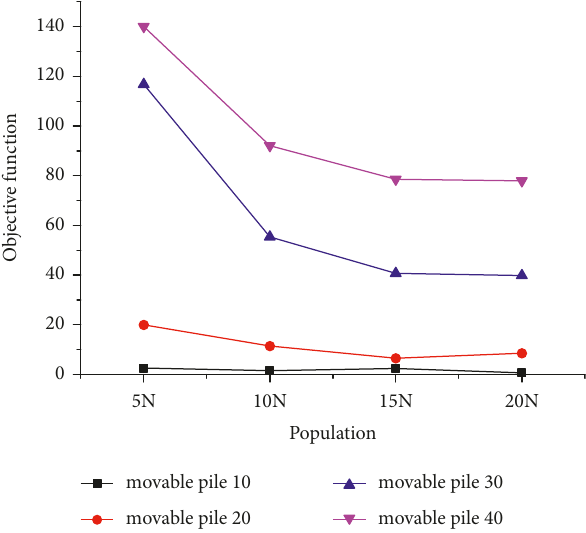
Figure 8: The influence of the population